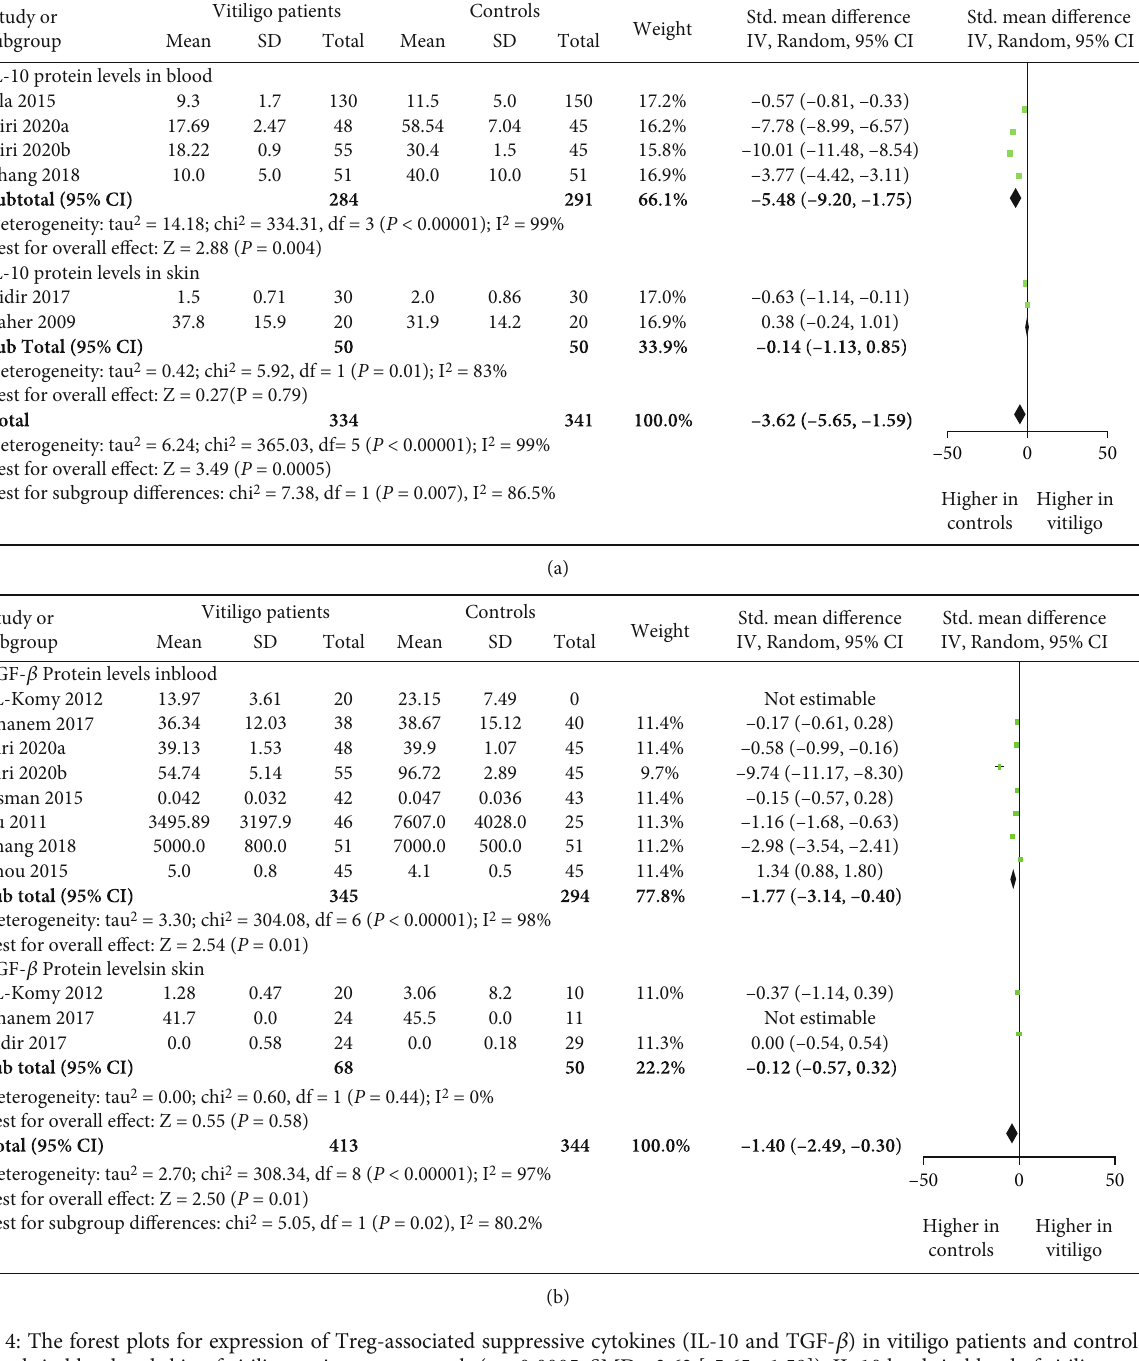
Figure 4: The forest plots for expression of Treg-associated suppressive cytokines (IL-10 and TGF- β ) in vitiligo patients and controls. (a) IL-10 levels in blood and skin of vitiligo patients vs. controls ( p = 0 : 0005 ; SMD: -3.62 [-5.65, -1.59]). IL-10 levels in blood of vitiligo patients vs. controls ( p = 0 : 004 ; SMD: -5.48[-9.20, -1.75]). IL-10 expression levels in skin of vitiligo patients vs. controls ( p = 0 : 79 ; SMD: -0.14 [-1.13, 0.85]). (b) TGF- β protein levels in blood and skin vitiligo patients vs. controls ( p = 0 : 01 , SMD: -1.40 [-2.49, -0.30]). TGF- β protein levels in blood of vitiligo patients vs. controls ( p = 0 : 01 , SMD: -1.77 [-3.14, -0.40]). TGF- β protein levels in skin of vitiligo patients vs. controls ( p = 0 : 58 , SMD: -0.12 [-0.57,